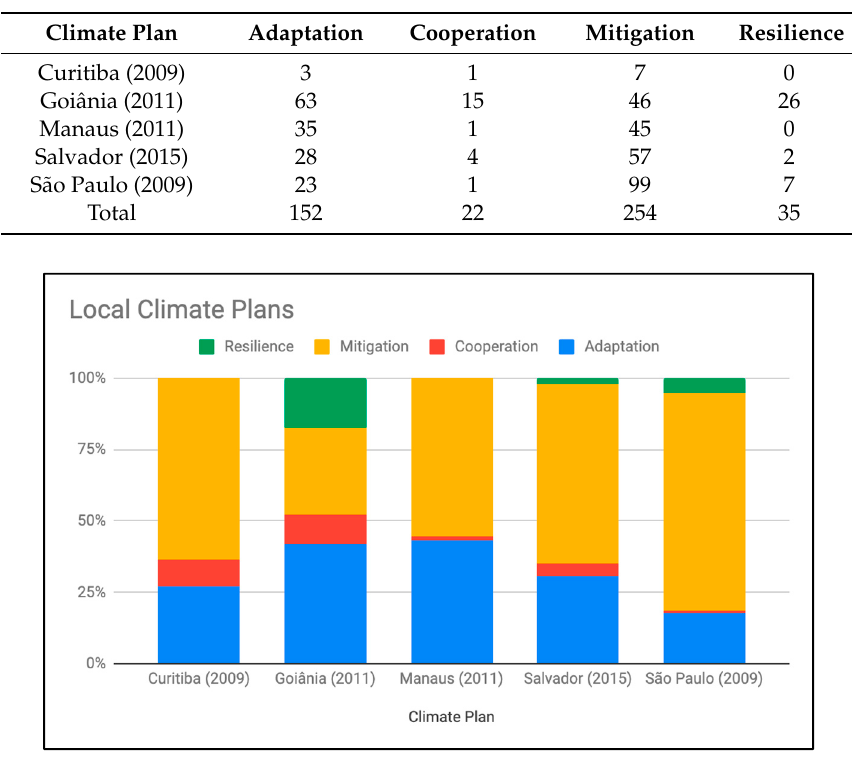
Figure 6. Climate action references in local climate plans.